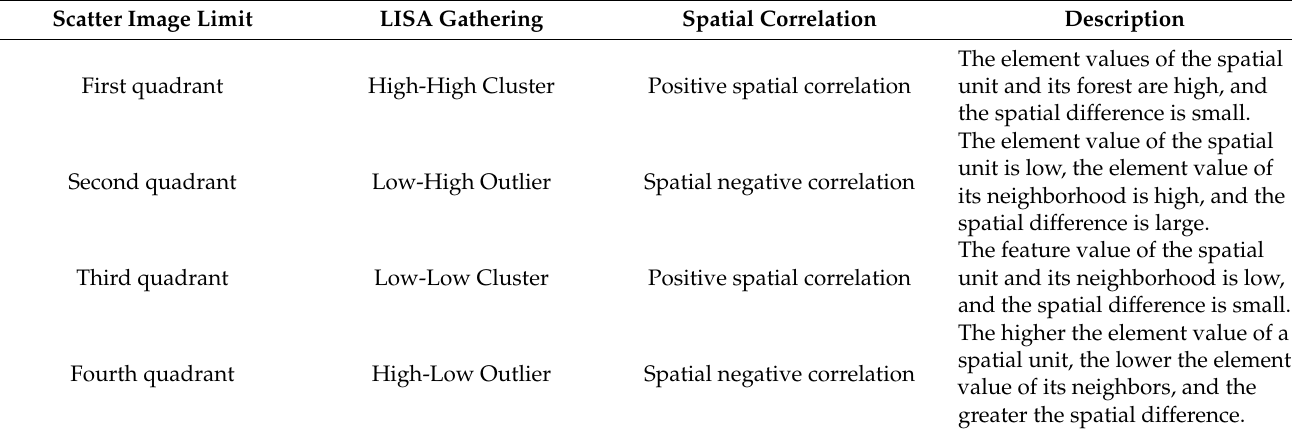
Table 1. Association pattern of Moran’s I scatter plot and LISA clustering map.